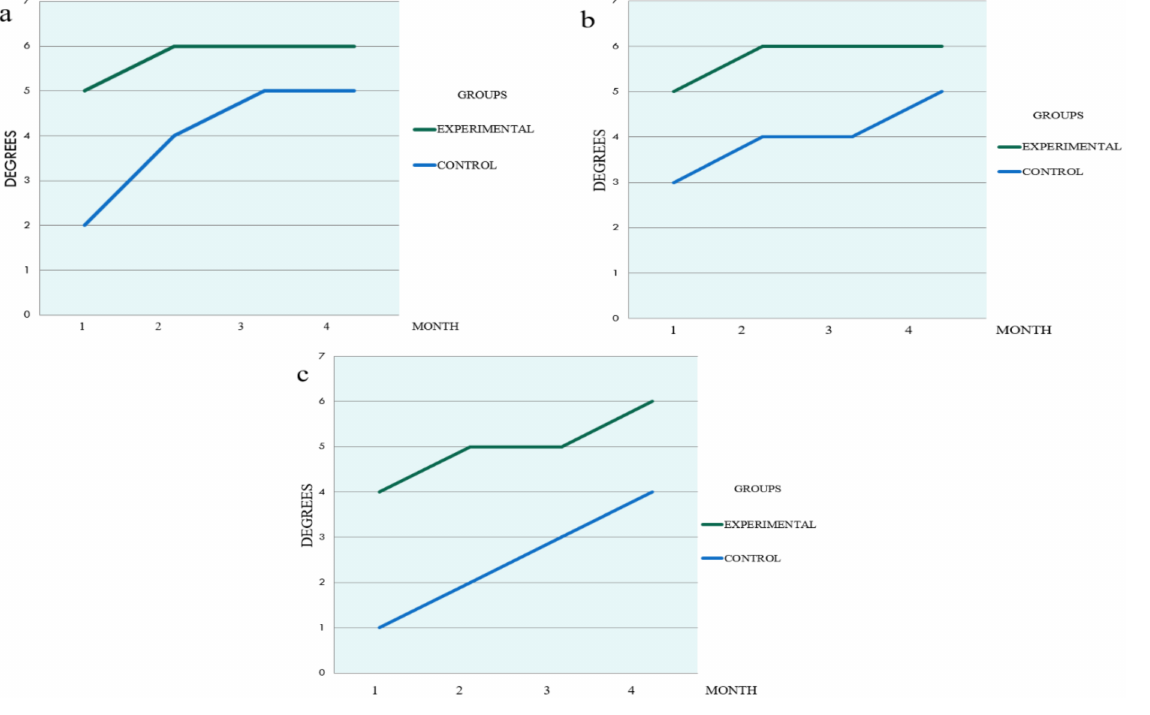
Figure 6. Areas Ro/BR 1-4, month evaluation ( a ) area A ( b ) area B ( c ) area C. Monthly significant difference, p = 0.002 was obtained with a sign test for Ro/BR between groups. In the Friedman test, a value of p = 0.0001 showed significant